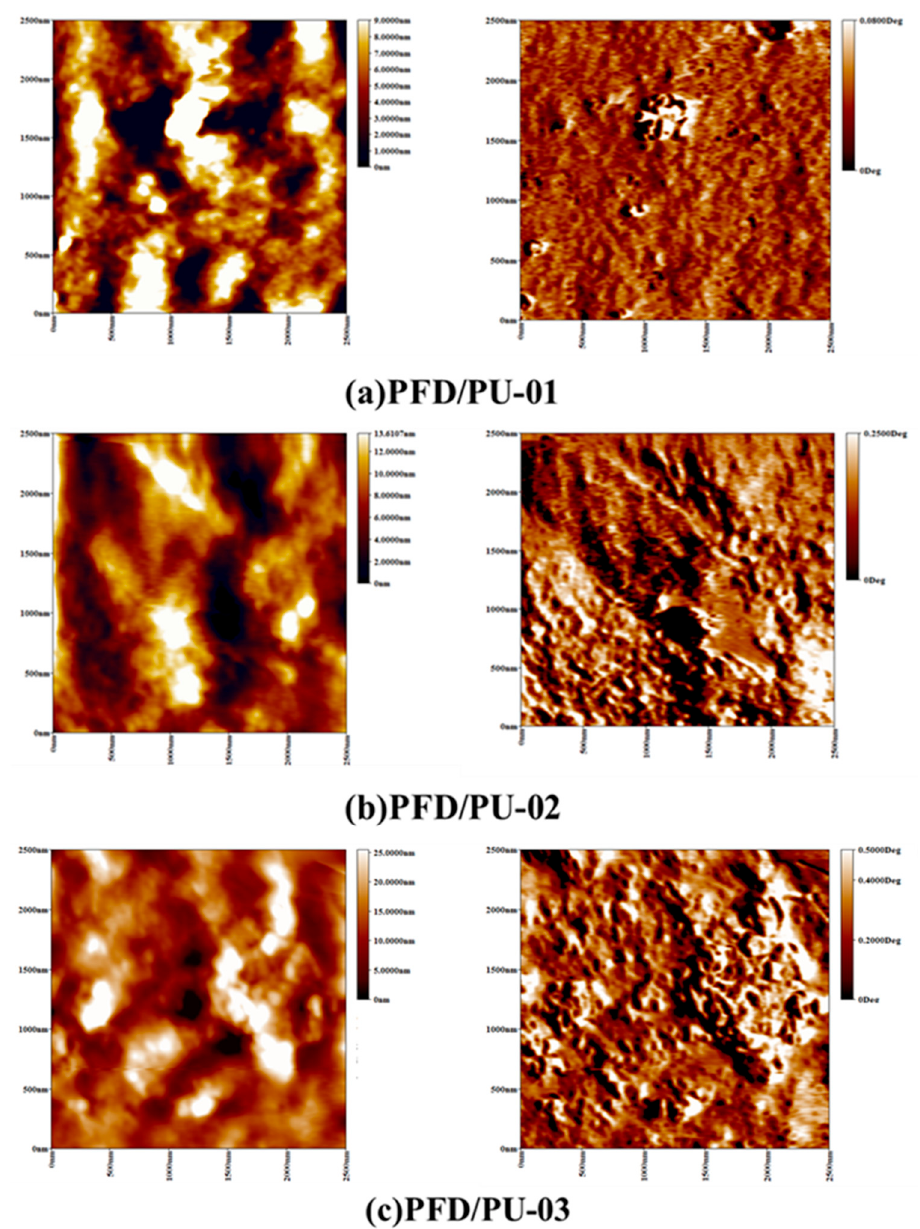
Figure 12. Atomic force microscopy (AFM) topographic and phase images of PFD/PUs: ( a ) PFD/PU-01, ( b ) PFD/PU-02, and ( c ) PFD/PU-03.